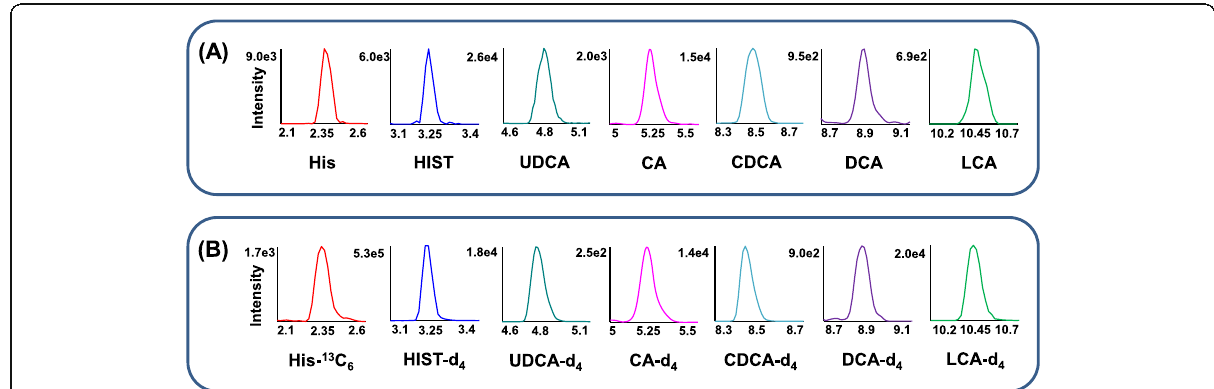
Fig. 5 MRM chromatograms of HIST, His, 5 BAs, and their corresponding internal standards in human gastric